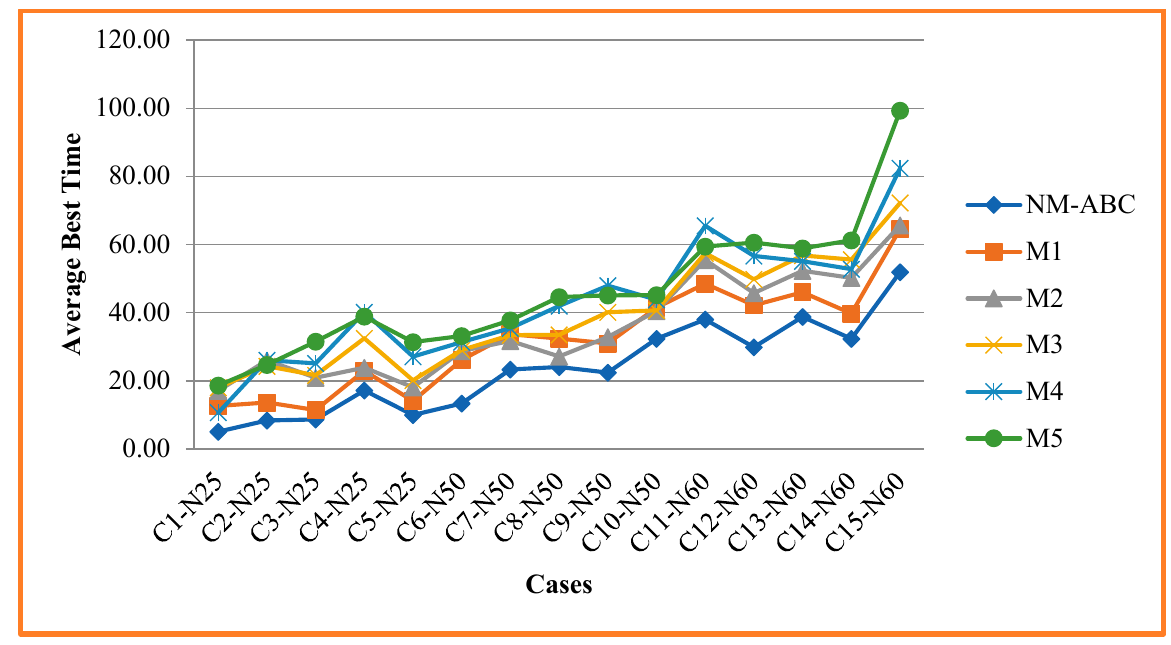
Figure 3. Analysis and Comparison of Average Best time.